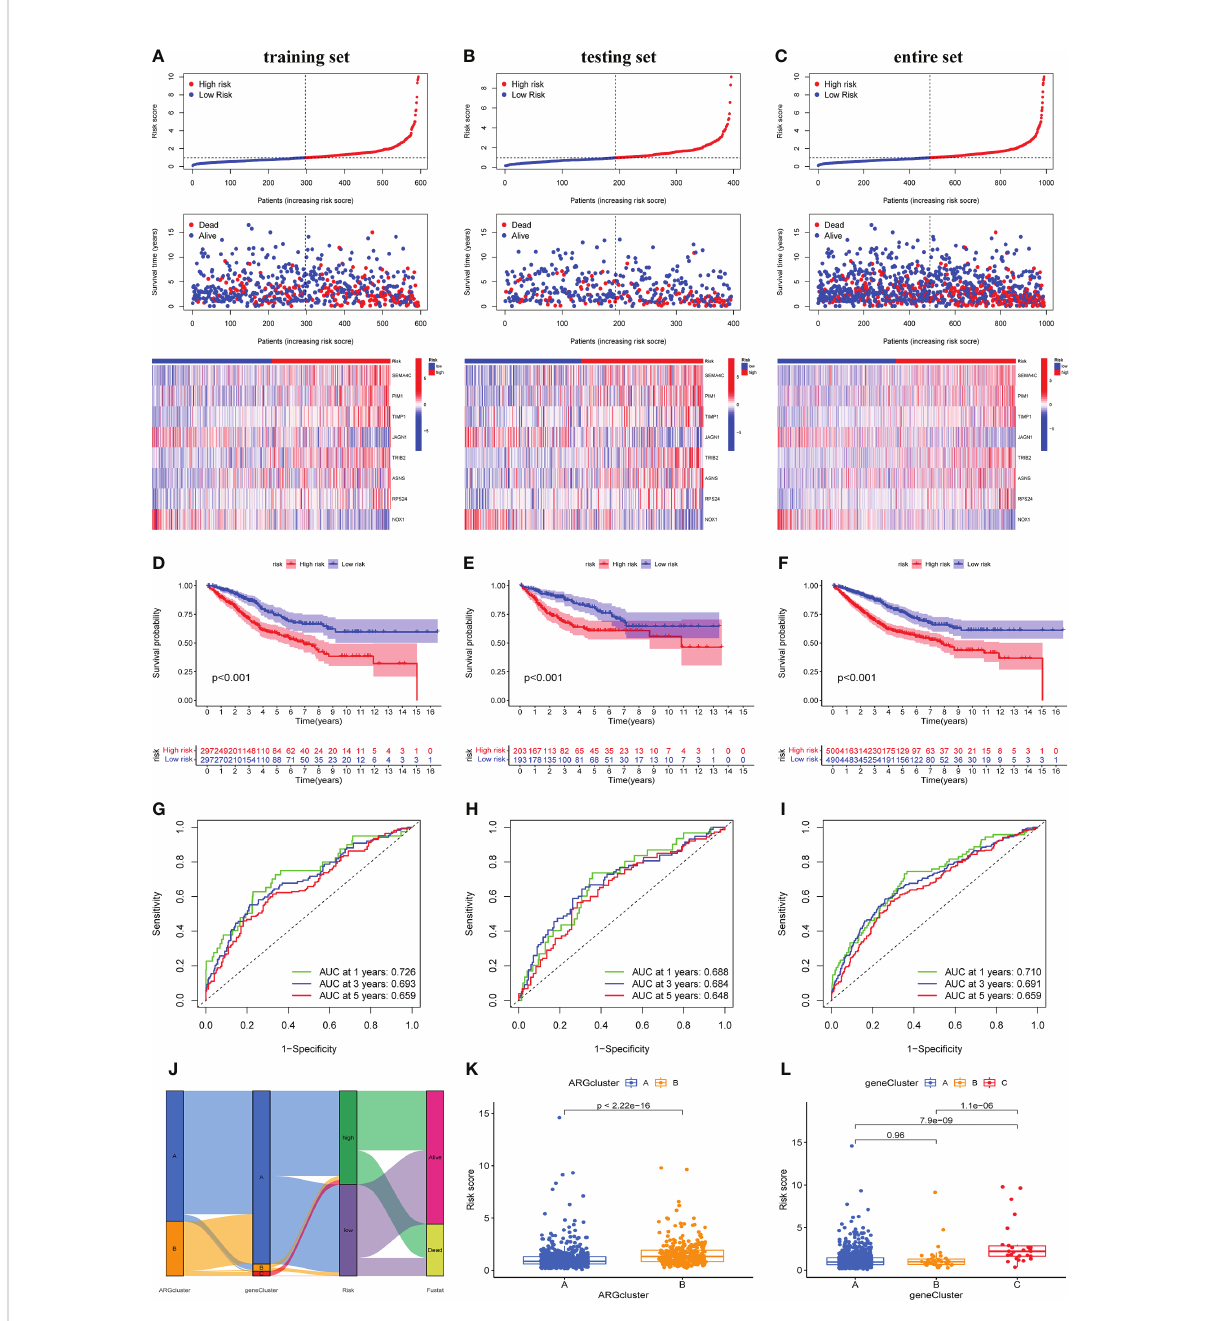
FIGURE 5 Construction and validation of the prognostic ARG score model. Signi fi cant differences in survival time and expression of 8 prognosis-related genes between high-risk and low-risk groups in training cohort (A) , testing cohort (B) and entire cohort (C) . Survival analysis of the overall survival (OS) for high-risk and low-risk patients in training cohort (D) , testing cohort (E) and entire cohort (F) . The ROC curves for 1-,3-,5-years survival of COAD patients in training cohort (G) , testing cohort (H) and entire cohort (I) . (J) Alluvial plot shows the distribution of patients in two ARGclusters, three gene clusters, two risk groups and their survival status. The differences in risk score of two ARGclusters (K) and three gene clusters (L)